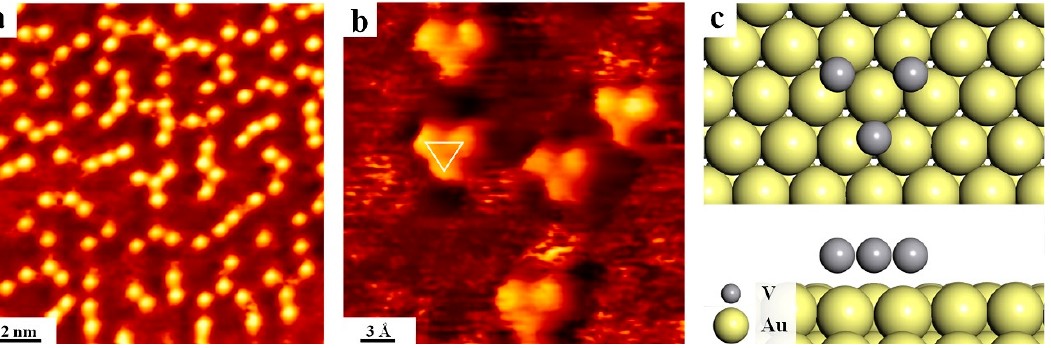
Figure 3. The observation of clusters formation on Au(111) after annealing at 480 °C. ( a ) The overview STM. ( b ) Zoom-in view showing the identical adsorption configuration. ( c ) Top and side views of the optimized model of the V cluster on Au(111). The cluster is marked with the white triangle. Scanning parameters: ( a ) U bias = − 0.9 V, I t = 0.6 nA; ( b ) U bias = − 0.6 V, I t = 4.2 nA.